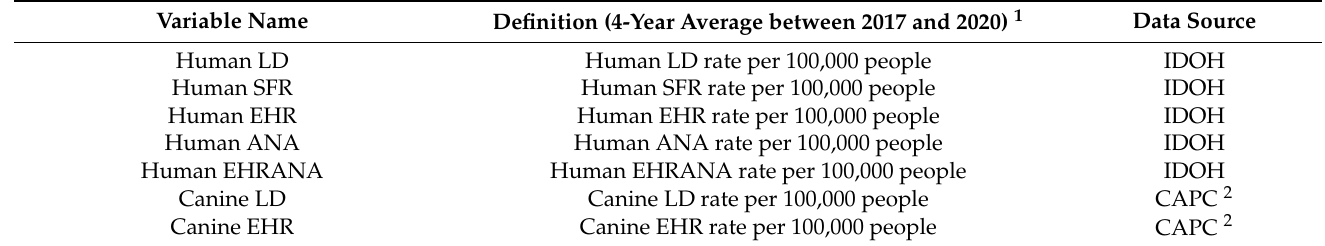
Table 1. Definition of variables and data sources. IDOH = Indiana Department of Health; CAPC = Companion Animal Parasite Council; IDNR = Indiana Department of Natural Resources; US = United